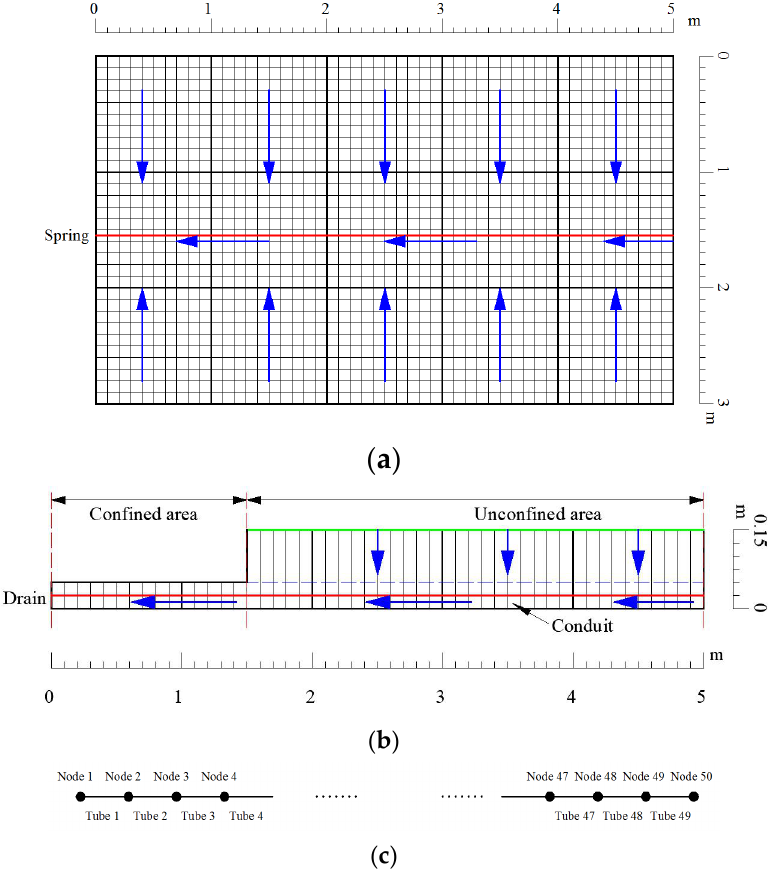
Figure 4. ( a ) Model configuration used for the simulations. The red line represents the center line of the conduit. The arrows indicate the groundwater flow directions. ( b ) Cross-section of the numerical model. The green line represents the flux recharge boundary. ( c ) The numbers of conduit nodes and tubes.